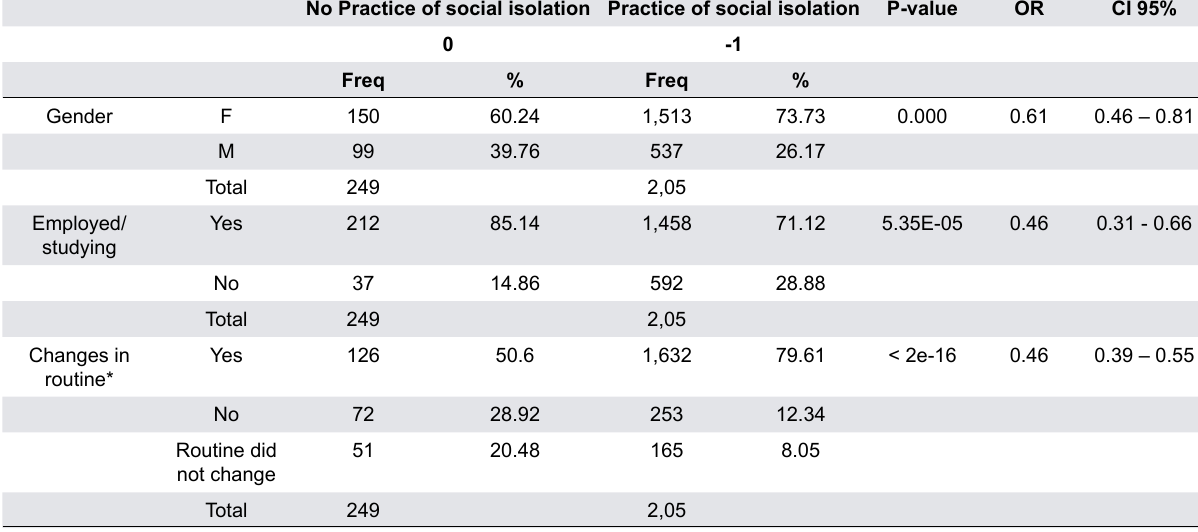
Impact event and orofacial pain amid the COVID-19 pandemic in Brazil: a cross-sectional epidemiological Table 3- Associations between practice of social isolation and gender, changes in routine, employment/studying